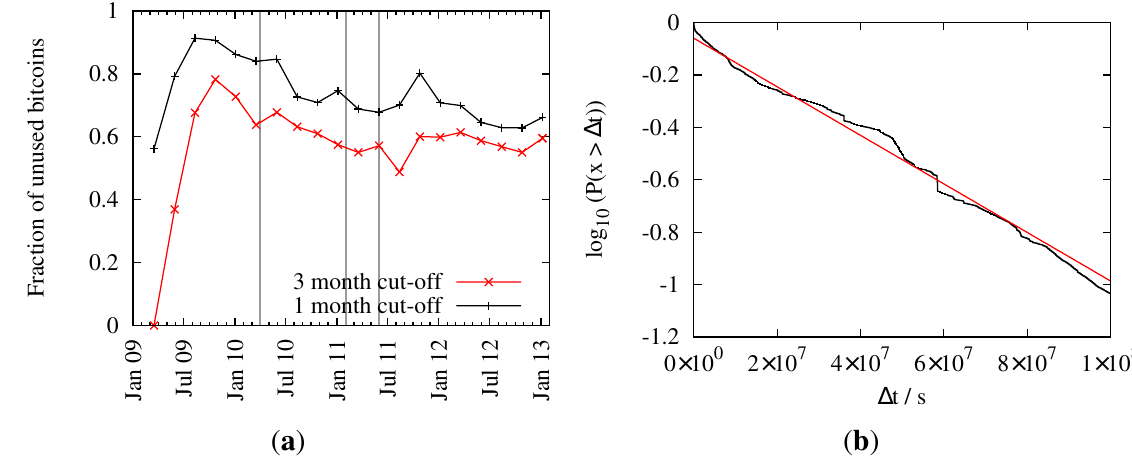
Figure 10. Time evolution of dormant coins. ( a ) Fraction of dormant coins for different cutoffs; ( b ) Probability P ( x > ∆ t ) that a bitcoin was not used for a certain amount of time ∆ t . The black line shows empirical data and the red line a fitted exponential